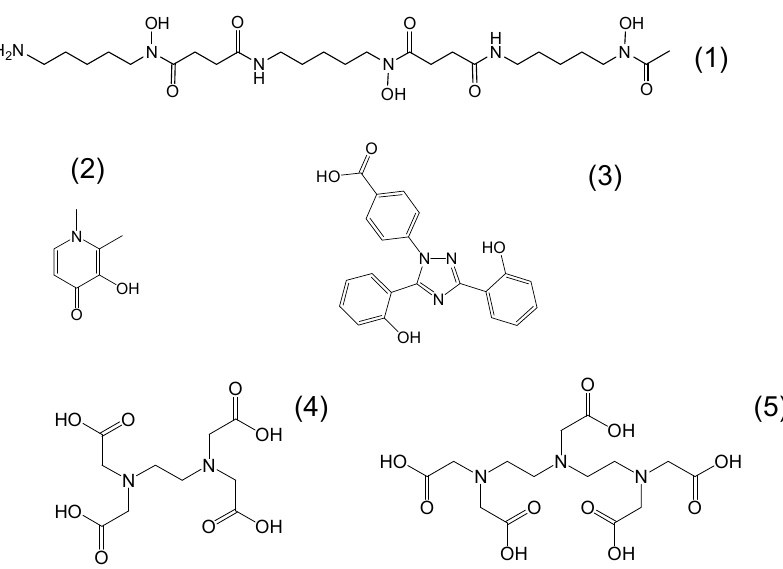
Figure 1. The chemical structure of the main iron chelating drugs. The main iron chelating drugs which are commercially available for the treatment of transfusional iron overload are deferoxamine or N ′ -{5-[acetyl(hydroxy) amino]pentyl}- N -[5-({4-[(5-aminopentyl)(hydroxy)amino]-4-oxobutanoyl}- amino)pentyl]- N -hydroxysuccinamide ( 1 ), deferiprone or 3-hydroxy-1,2-dimethylpyridin-4(1 H )-one ( 2 ) and deferasirox or 4-[(3 Z ,5 E )-3,5-bis(6-oxo-1-cyclohexa-2,4-dienylidene)-1,2,4-triazolidin-1-yl]-benzoic acid ( 3 ). The other two chelating drugs EDTA or 2-({2-[bis(carboxymethyl)-amino]ethyl}(carboxymethyl) amino)acetic acid ( 4 ) and DTPA or 2-[bis[2-[bis(carboxymethyl)amino]-ethyl]amino]acetic acid ( 5 ) are not currently used for iron detoxification but for other metal detoxification and other clinical conditions (see text).